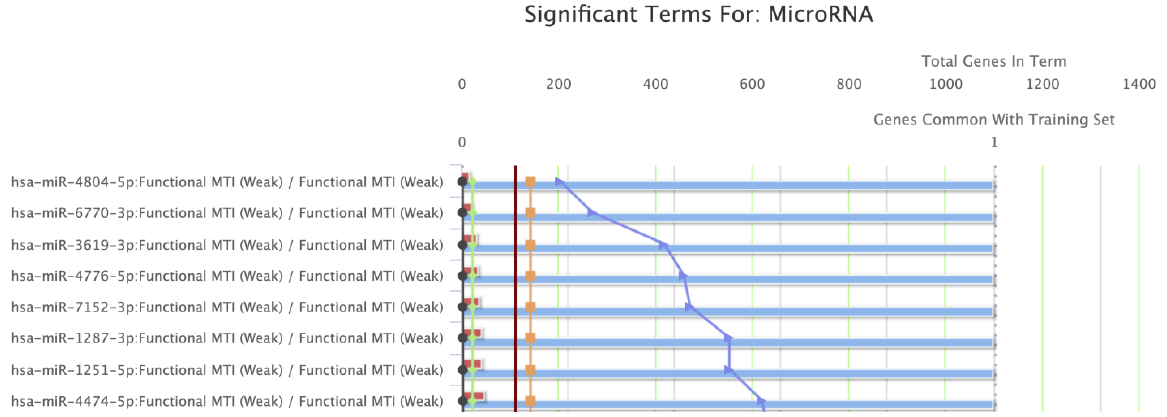
Figure 6. Gene Set Enrichment Analysis (GSEA) indicated miRNA families that are important reg-